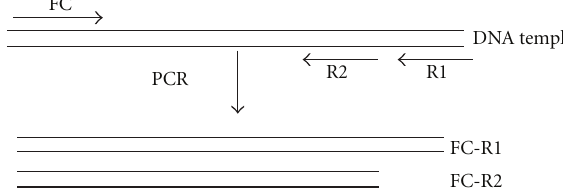
Figure 1: Diagram of primers designed for each locus. FC, the forward primer, is the common primer; R1 and R2 are the pair of reverse primers. The amplicons FCR1 and FC-R2 are amplified from each locus.